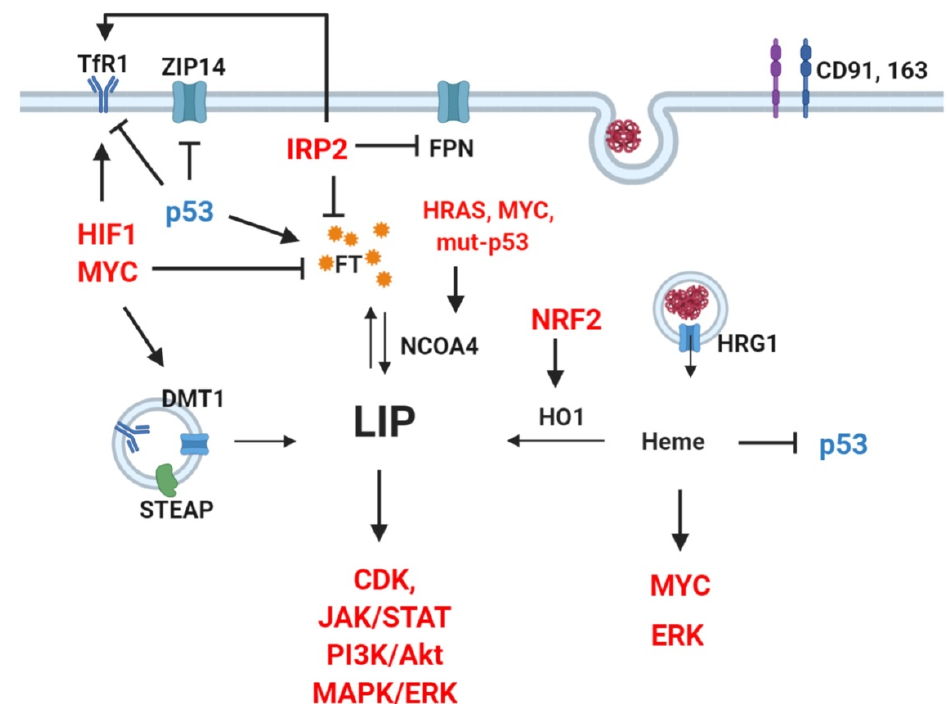
Figure 2. Crosstalk between oncogenes, signaling pathways, and iron regulators. Red: upregulation reported in cancer. Blue: downregulation reported in cancer. Several oncogenic transcription factors, signaling pathways, and proto-oncogenes directly regulate key players of iron metabolism. Notably, TfR1 upregulation can be caused by activation of HIF1 and MYC overexpression of IRP2, or loss of wild-type p53 [51,155,184,185]. Similarly, ferritin (FT) decrease can result from activation of MYC, IRP2, or p53 mutation [51,155,185]. Such a vicious cycle is sustained as increased LIP promotes CDK, JAK / STAT, PI3K, MAPK / ERK pathways [172], whereas heme can further enhance ERK and MYC and inhibits p53 [181,186,187] .